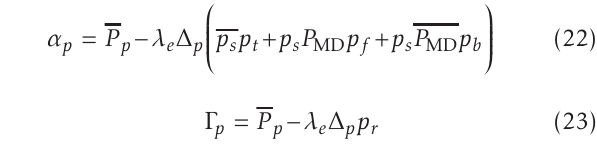
Figure 3. Markov chain of the PU for the feedback-based access scheme under dominant system S α − α p = 1 p . State self-transitions are not depicted for visual